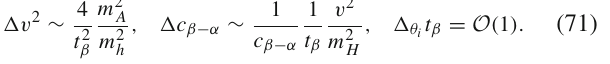
Fig. 14 The same as Fig. 8 for Scenario